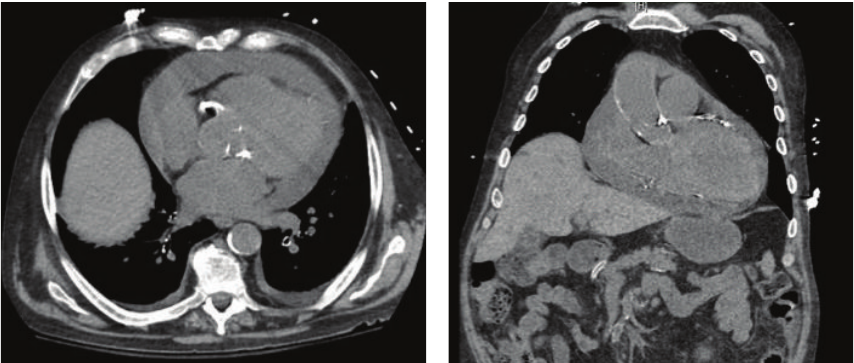
Figure 2: CT imaging demonstrated large pericardial